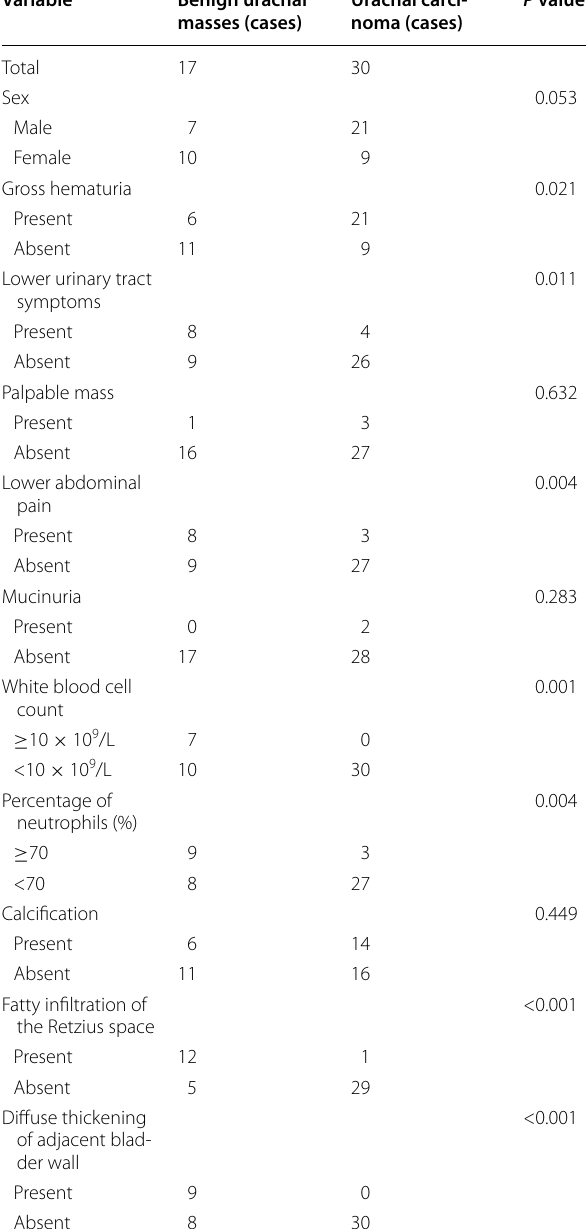
Table 1 Univariate analysis of all 12 parameters compared between patients with benign urachal masses and those with urachal carcinoma